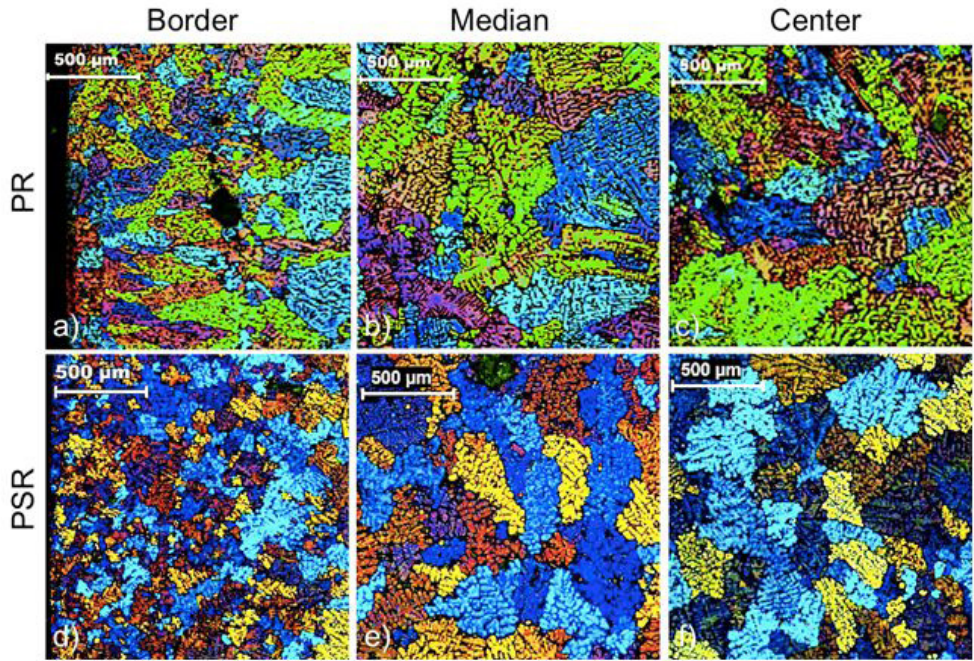
Figure 7. PL microstructure at three locations along a radial cross section of region 1 of an ingot (edge - a, d; middle - b, e; centre - c, f) cast by route 4 with EMS (3000 W) (a-f) and PC (a-c) and PSC (d-f).